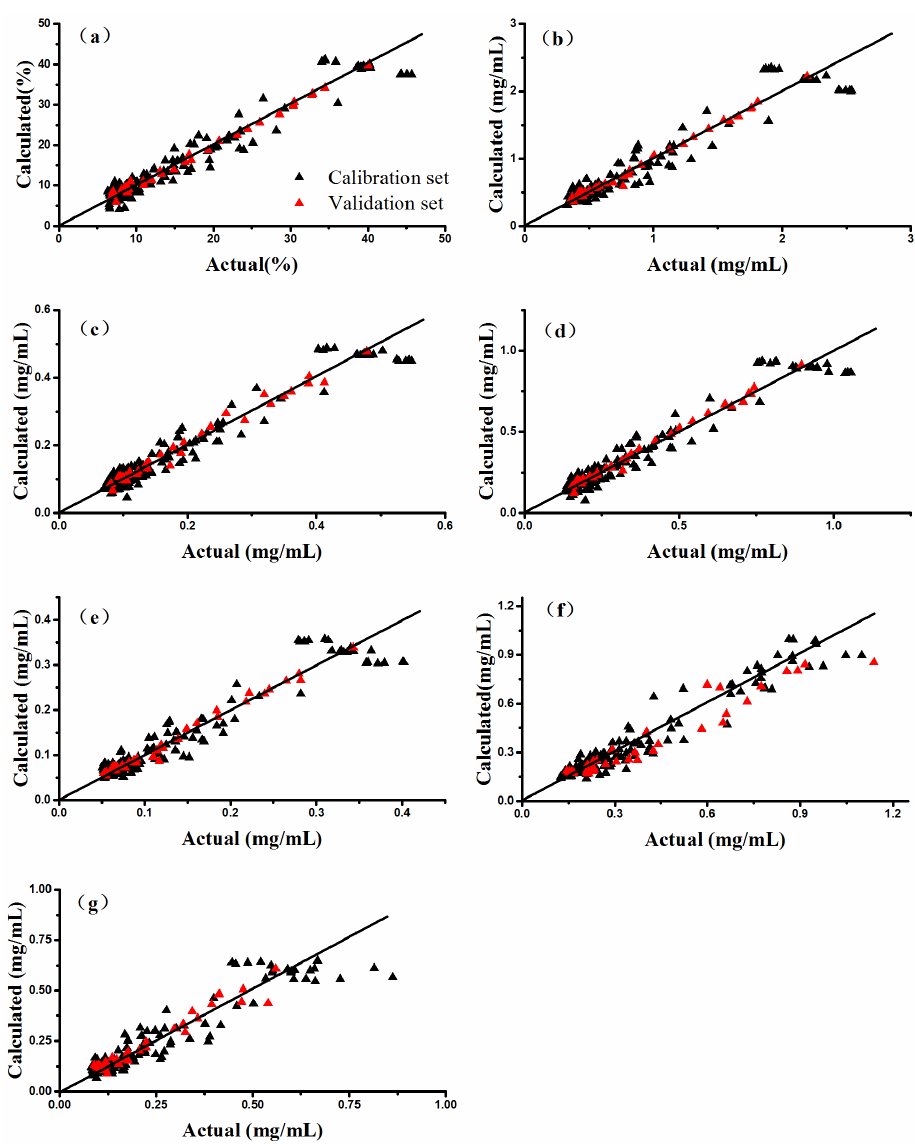
Figure 4. Correlation plots for reference values versus NIR predictions for the PLSR models of TS ( a ), CG ( b ), FG ( c ), DPGP ( d ), DDIFGP ( e ), AG II ( f ), and AG IV ( g